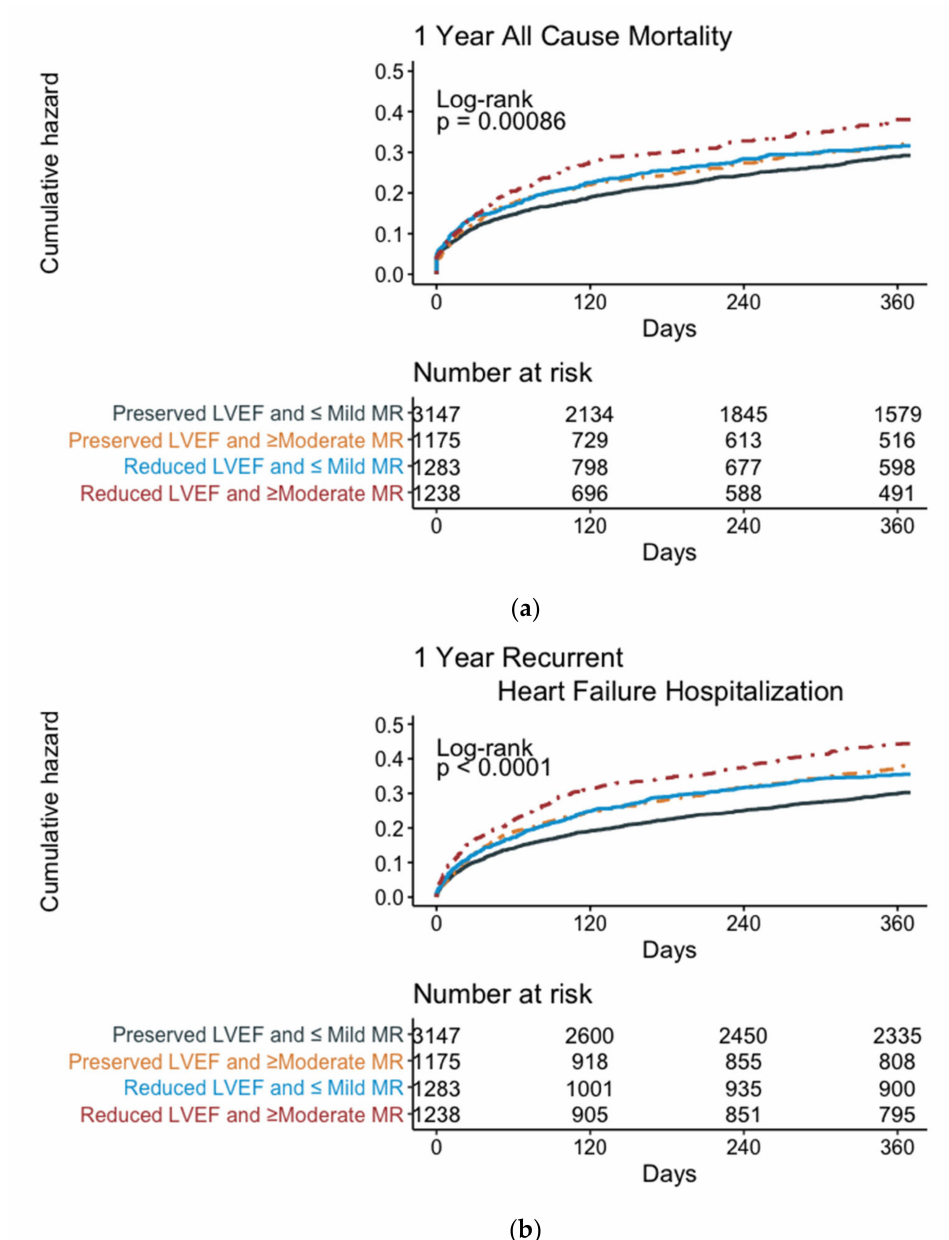
Figure 3. Kaplan–Meier curves for ( a ) 1-year all-cause mortality and ( b ) 1-year recurrent hospitaliza- tion according to LVEF and MR